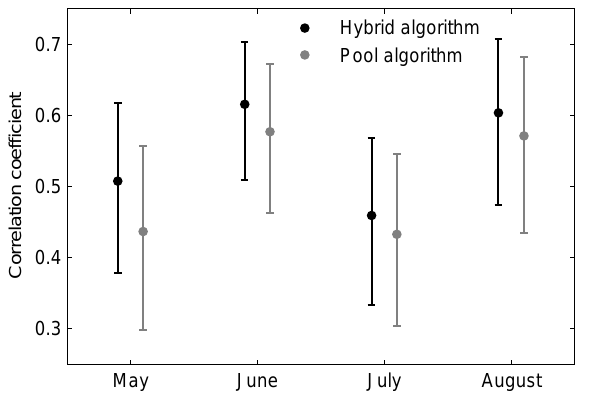
Fig. 4. Monthly correlations between the measured monoterpene emissions and the emissions given by the two algorithms during the summer 2007. The error bars show the 95% confidence